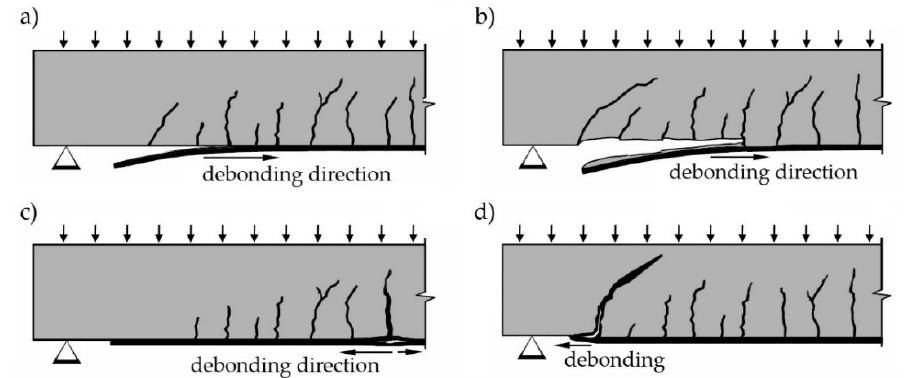
Figure 1. Debonding failure modes: ( a ) plate end interfacial debonding; ( b ) concrete cover separation; ( c ) intermediate flexural crack-induced debonding; ( d ) critical diagonal shear crack-induced